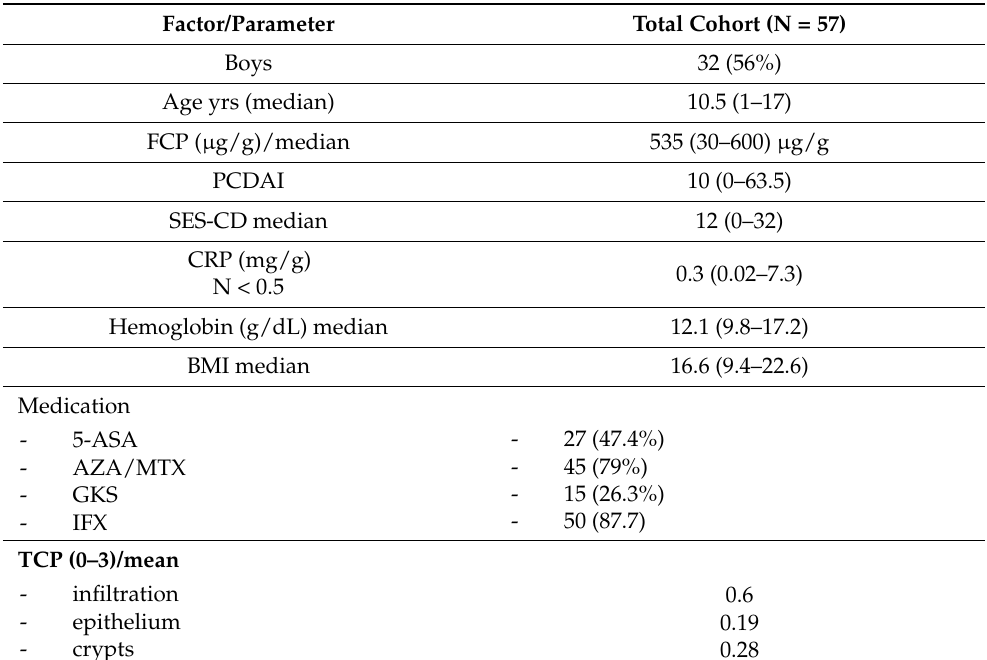
Table 1. Characteristics of the study group, including clinical, laboratory, endoscopic and histopatho- logical